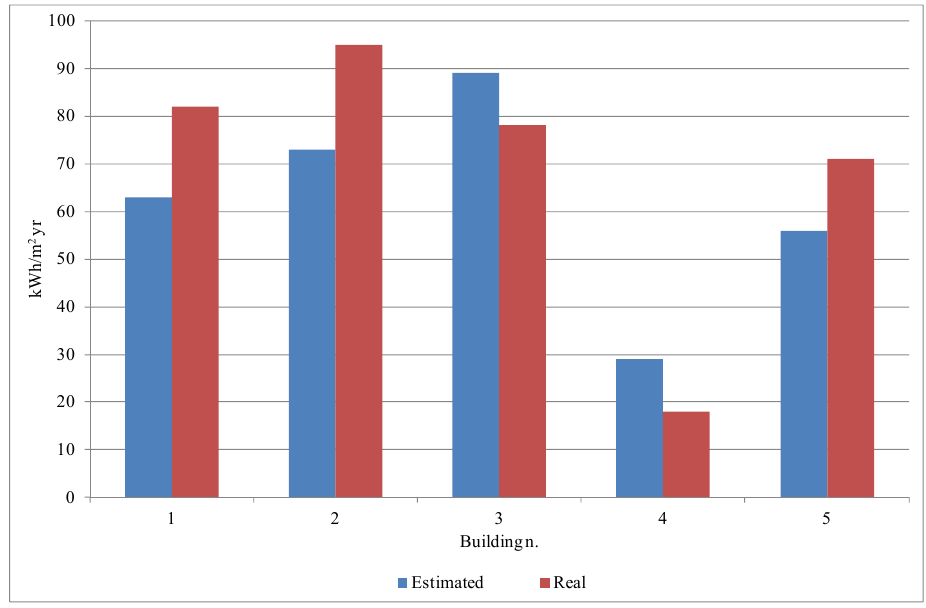
Figure 12. Estimated energy needs and real energy consumption for the reference flats (kW·h/m 2